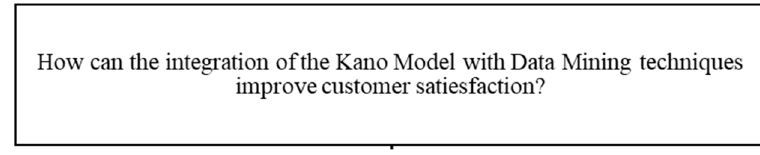
Figure 1. Research problem.